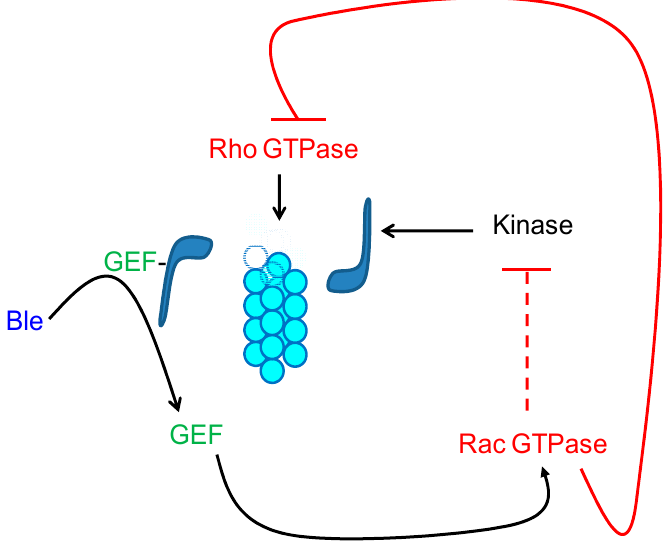
Figure 9. Diagram representing how the presence of blebbistatin (Ble) could trigger the activation of the Rac GTPase by means of the release of their guanosine nucleotide exchange factors (GEFs). The activity of the Rac GTPase would block myosin phosphorylation via the corresponding kinase. In turn, the Rac GTPase inhibition would stimulate Rho GTPase activation and polymerization of the